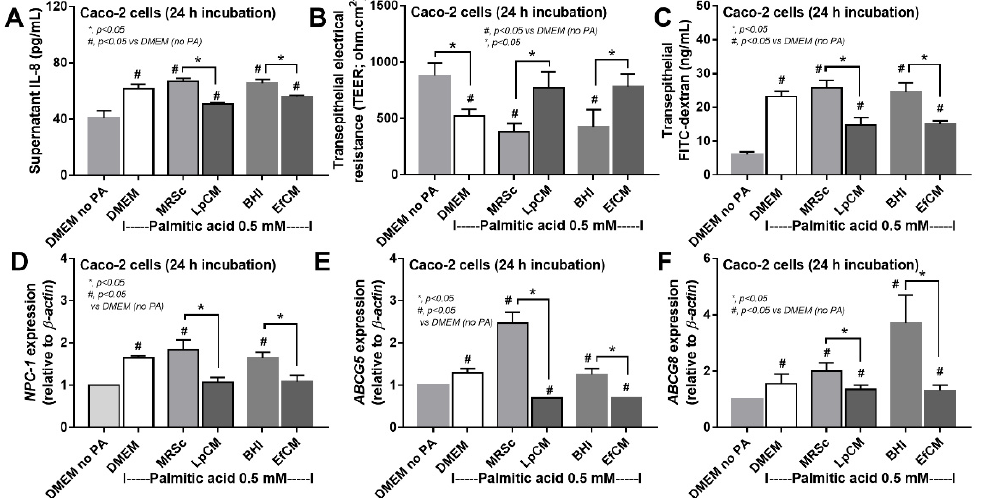
Figure 4. Characteristics of Caco-2 cells (enterocytes) with 0.5 mM palmitic acid (PA) with or without condition media of Lactiplantibacillus plantarum (LpCM) or Enterococcus faecium (EfCM) as indicated by supernatant IL-8 ( A ), transepithelial electrical resistance (TEER) ( B ), transepithelial FITC-dextran ( C ) and gene expression of cholesterol absorption associated molecules, including NPC-1 (NPC Intracellular Cholesterol Transporter 1), ABCG5 (ATP Binding Cassette Subfamily G Member 5) and ABCG8 (ATP Binding Cassette Subfamily G Member 8), ( D – F ) are demonstrated. Notably, MRSc (De Man, Rogosa and Sharpe broth) and) and BHI (Brain Heart Infusion broth) were the culture media for Lp and Ef, respectively, and independent triplicate experiments were performed for all